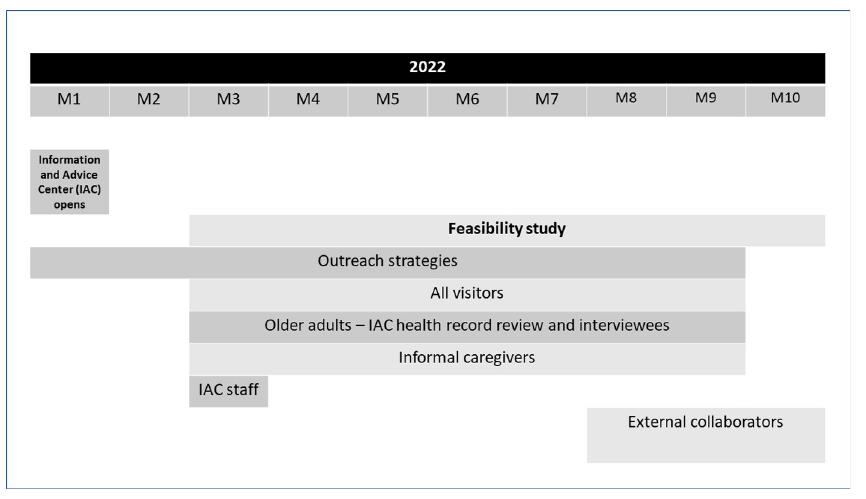
Fig 2. Recruitment timeline. M =